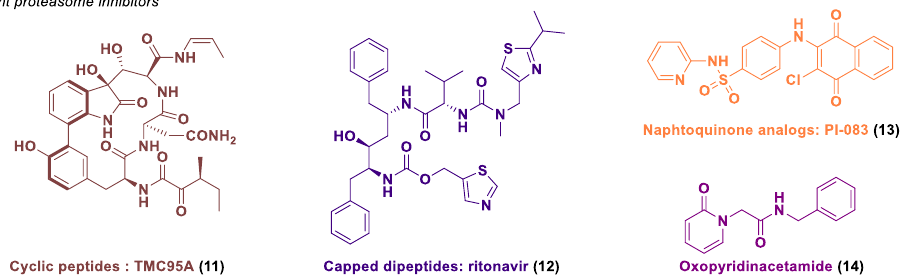
Figure 1. Representative examples of the major classes of covalent ( a ) and non-covalent ( b ) PIs from natural and synthetic sources.